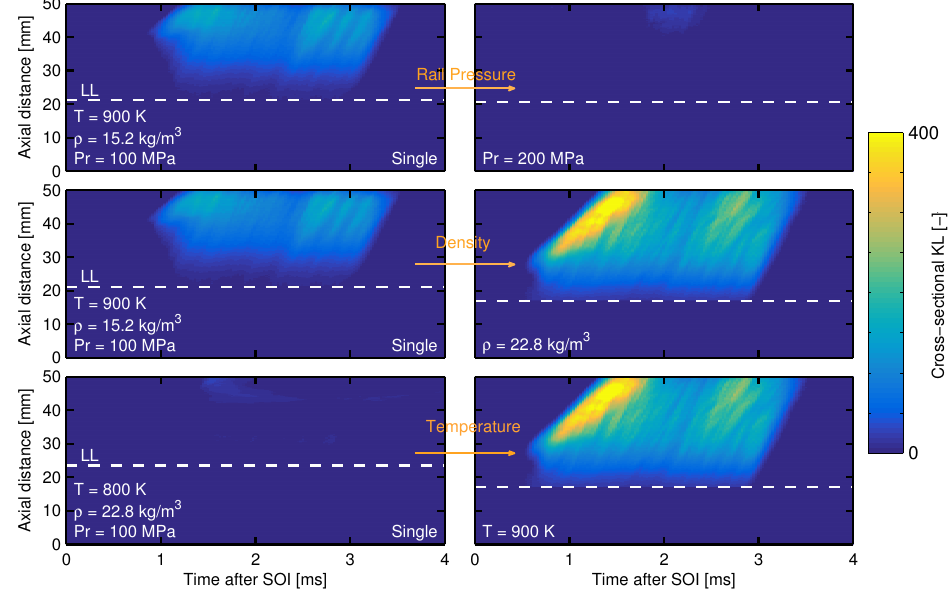
Figure 12. Effect of the rail pressure, chamber density, and chamber temperature, divided row-wise respectively, on the evolution of the cross-sectional optical thickness (KL) at each axial distance for single injection events. The dashed white line represents the liquid length for each specific condition and the orange arrows represent the direction of the variable